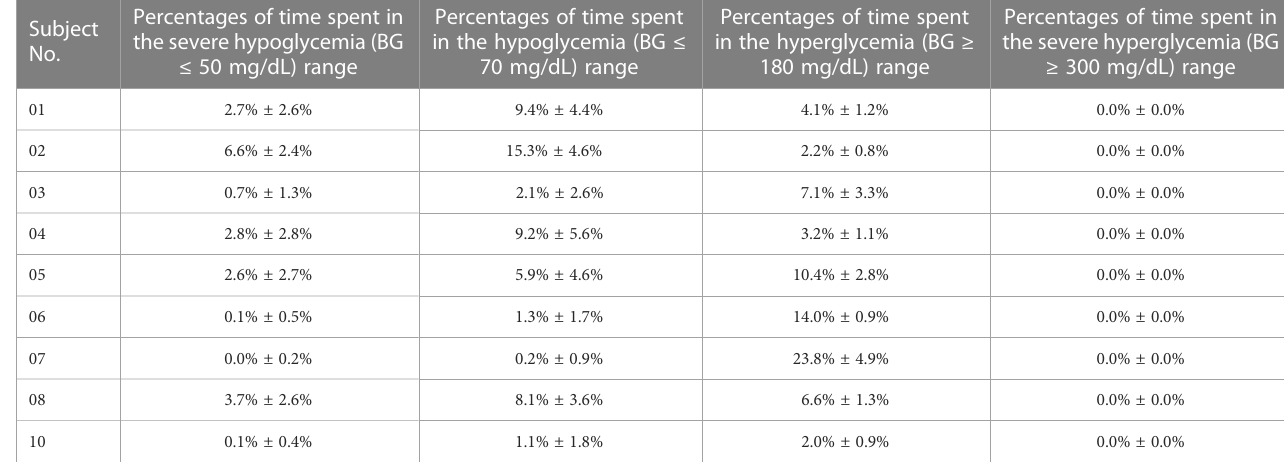
TABLE 4 Percentages of time spent in the severe hypoglycemia (BG ≤ 50 mg/dL) range, the hypoglycemia (BG ≤ 70 mg/dL) range, the hyperglycemia range (BG > 180 mg/dL), and the severe hyperglycemia range (BG > 300 mg/dL) of each in-silico subject with the GPC+IOB+AW controller. Percentages of time spent in Subject the severe hypoglycemia (BG No. ≤ 50 mg/dL)